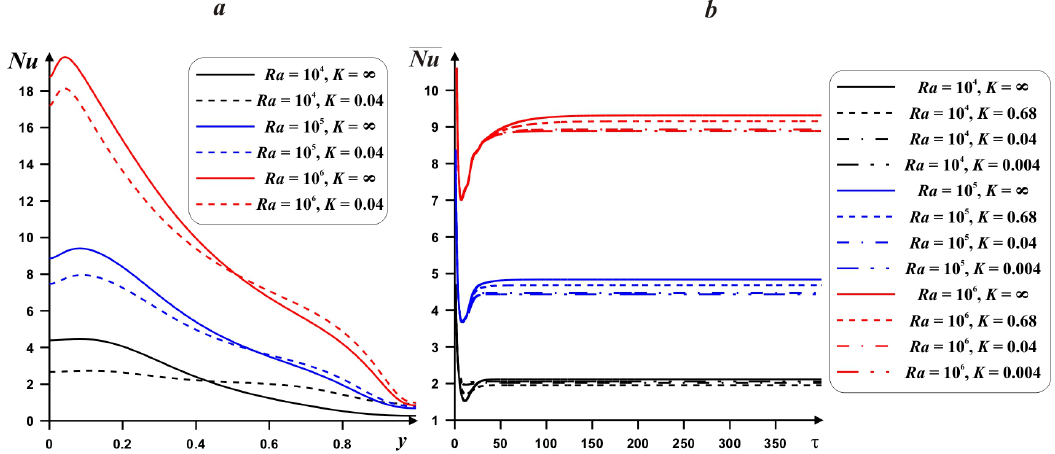
Figure 9. Local Nu profiles ( a ) and time-dependent mean Nu profiles ( b ) for δ = 0.5, φ = 0.02 and different Ra and K .